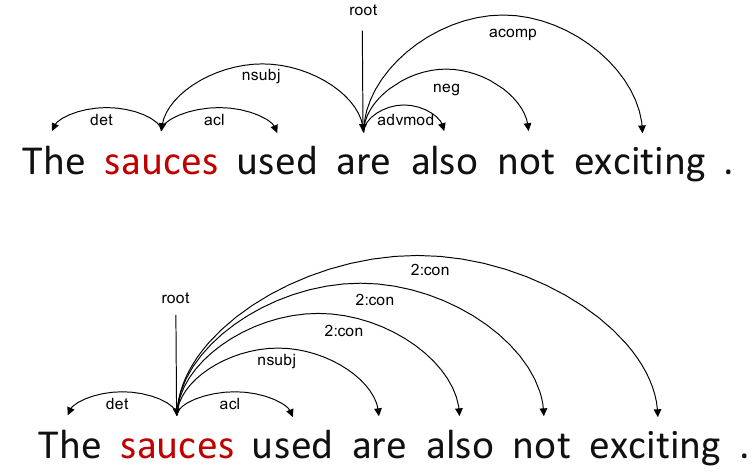
Figure 2. Reconstruction of aspect-oriented syntax dependency